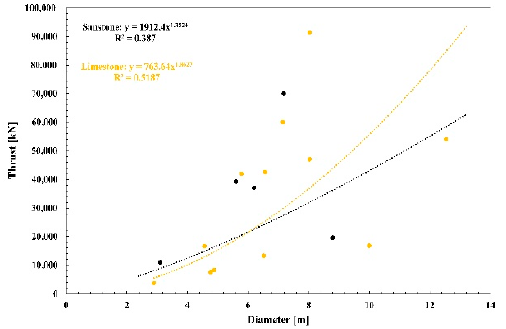
Figure 14. Correlation between the diameter and the thrust due to the excavation in sandstone and limestone by single shield TBMs.